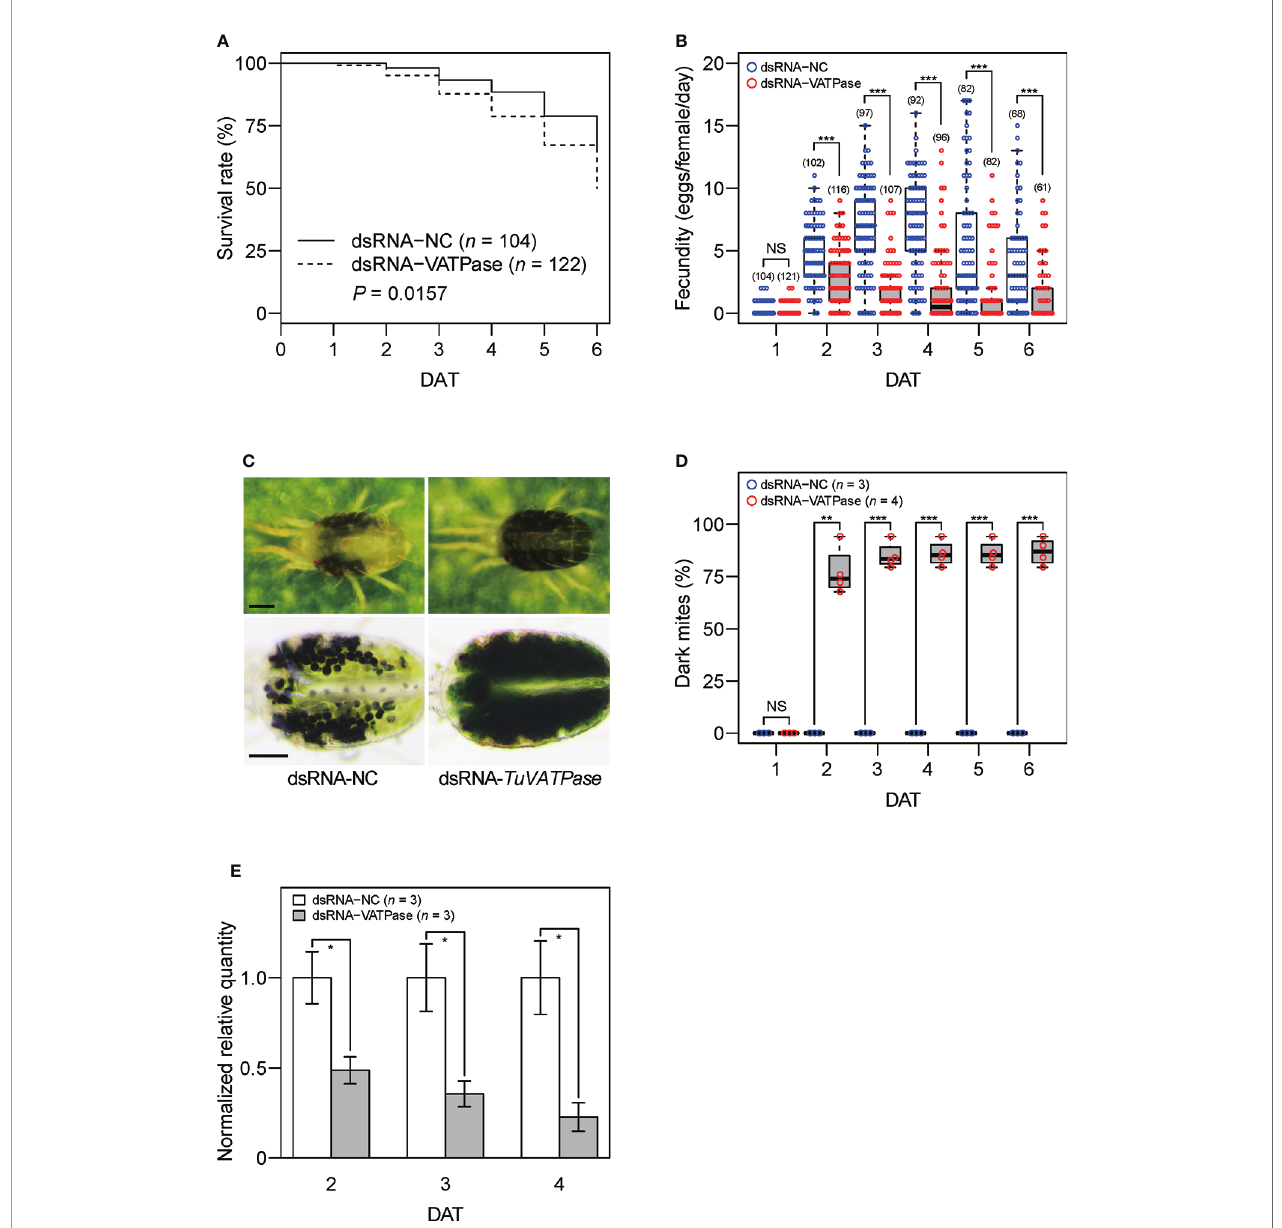
FIGURE 3 | The effect of 1 µg µl − 1 dsRNA- TuVATPase or dsRNA-NC (negative control) delivered via the mesh method on the survivorship, fecundity, and endogenous TuVATPase gene expression in adult Tetranychus urticae females at 25°C. (A) Survivorship of adult females for 6 days after treatment (DAT) with dsRNA- TuVATPase and dsRNA-NC. Survival curves were plotted by using the Kaplan – Meier method and compared by using the log-rank test. (B) Daily fecundity of adult females that survived after treatment with dsRNA- TuVATPase and dsRNA-NC. Data were represented by bee-swarm and box-and-whisker plots and compared by using Wilcoxon – Mann – Whitney tests (NS, P > 0.05; ***, P < 0.001). Values in parentheses indicate the number of surviving mites. (C) Mite body phenotype associated with dsRNA treatment. Lower photos are of mites soaked in a 50% (v/v) glycerol and 0.1% (v/v) Triton X-100 solution. Scale bar: 100 µm. (D) Cumulative frequency of dark-body phenotype observed after treatment with dsRNA- TuVATPase and dsRNA-NC. Data were represented by bee-swarm and box-and-whisker plots and compared by using a t -test after normalization with arcsine square-root transformation (NS, P > 0.05; **, P < 0.01; ***, P < 0.001). Data were collected from four and three independent experimental runs for treatments with dsRNA- TuVATPase ( n = 4) and dsRNA-NC ( n = 3), respectively. In each experimental run, 25 to 42 mites were used. (E) TuVATPase gene expression relative to the expression of RP49 reference gene at 2, 3, and 4 days after treatment with dsRNA- TuVATPase and dsRNA-NC. Data were represented as mean ± SE and compared by using a t -test (*, P < 0.05). (A, B, E) Data were collected from three independent experimental runs. (B, D) In the box-and-whisker plots, the central line (second quartile, Q2) indicates the median, the distance between the box bottom ( fi rst quartile, Q1) and top (third quartile, Q3) indicates the interquartile range (IQR), and the whisker bottom and top indicate the minimum and maximum values, respectively. Outliers that are outside the range between the lower [Q1 − 1.5 × IQR] and upper limits [Q3 + 1.5 × IQR] are plotted outside of the